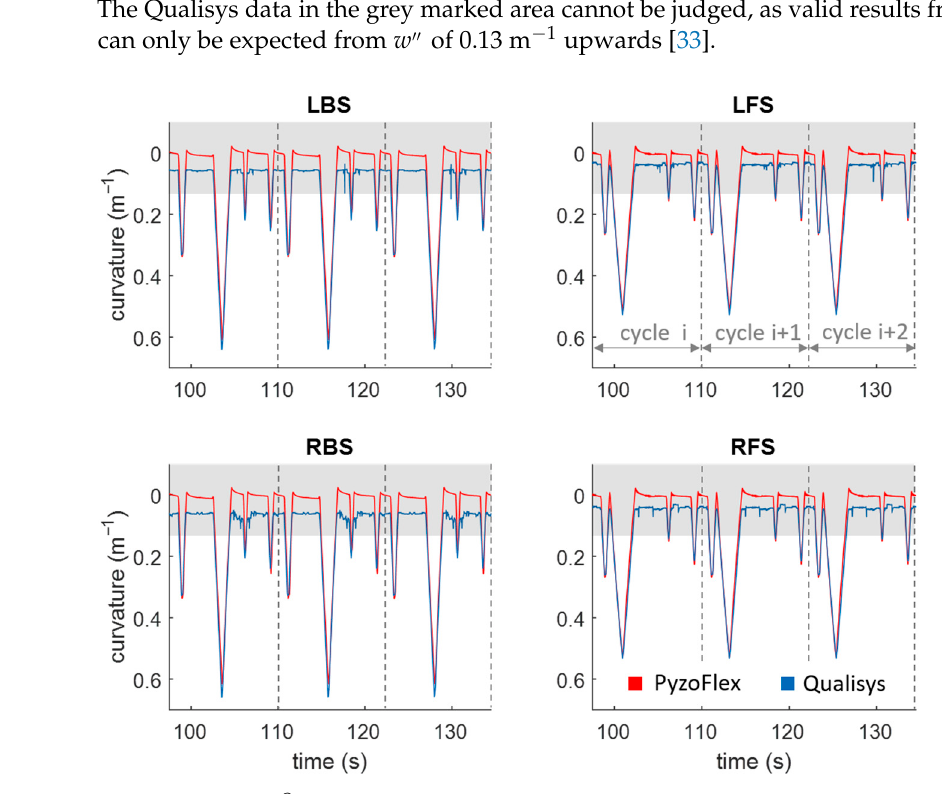
Figure 6. PyzoFlex ® signal in red and Qualisys (QTM) signal in blue over three cycles during dynamic loading at v medium . A differentiation is made between the posterior (LBS: left posterior segment, RBS: right posterior segment) and the anterior deflection segments (LFS: left anterior segment, RFS: right anterior segment).